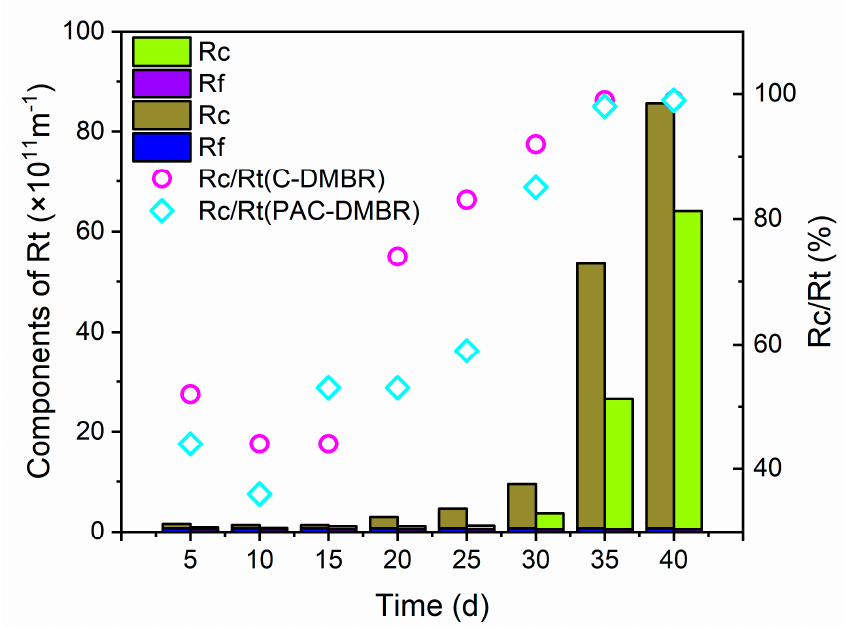
Figure 5. Resistances of two systems during operation time.